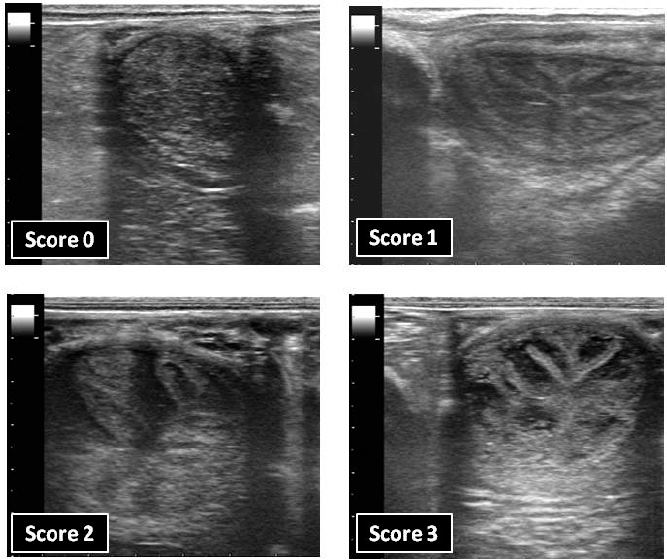
Figure 1. Representative B-mode ultrasonograms of the endometrial oedema scoring